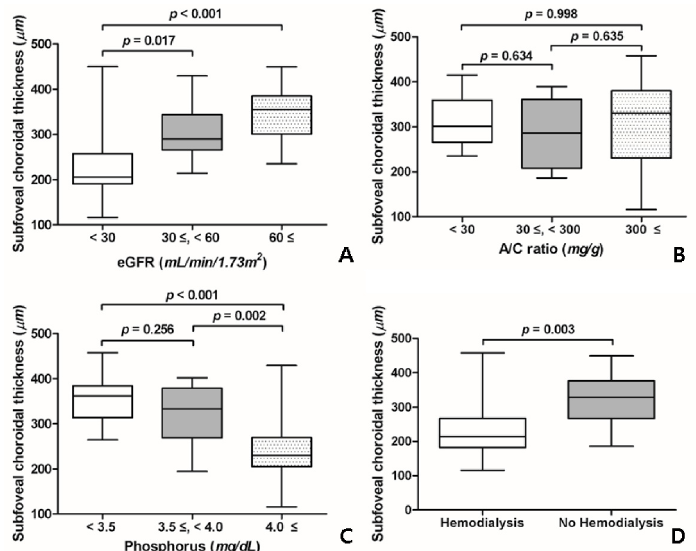
Figure 3. Changes in subfoveal choroidal thickness (SFChT) according to renal function. ( A ) Changes in SFChT according to the estimated glomerular filtration rate (eGFR). Patients with advanced nephropathy tended to have less SFChT. SFChT of patients with eGFR < 30 mL/min/1.73 m 2 was significantly lesser than that of patients with eGFR ≥ 60 mL/min/1.73 m 2 and those with eGFR 30–60 mL/min/1.73 m 2 . ( B ) Changes in SFChT according to the urine albumin/creatinine (A/C) ratio. SFChTs of patients were not significantly different when analyzed according to the severity of urine albumin/creatinine ratio. ( C ) Changes in SFChT according to the serum phosphorus level. Patients with higher serum phosphorus levels had significantly less SFChT than those with lower serum phosphorus levels. ( D ) The difference between SFChT of patients who underwent renal replacement therapy and that of those who did not. Patients who underwent dialysis had significantly less SFChT than those who did not.